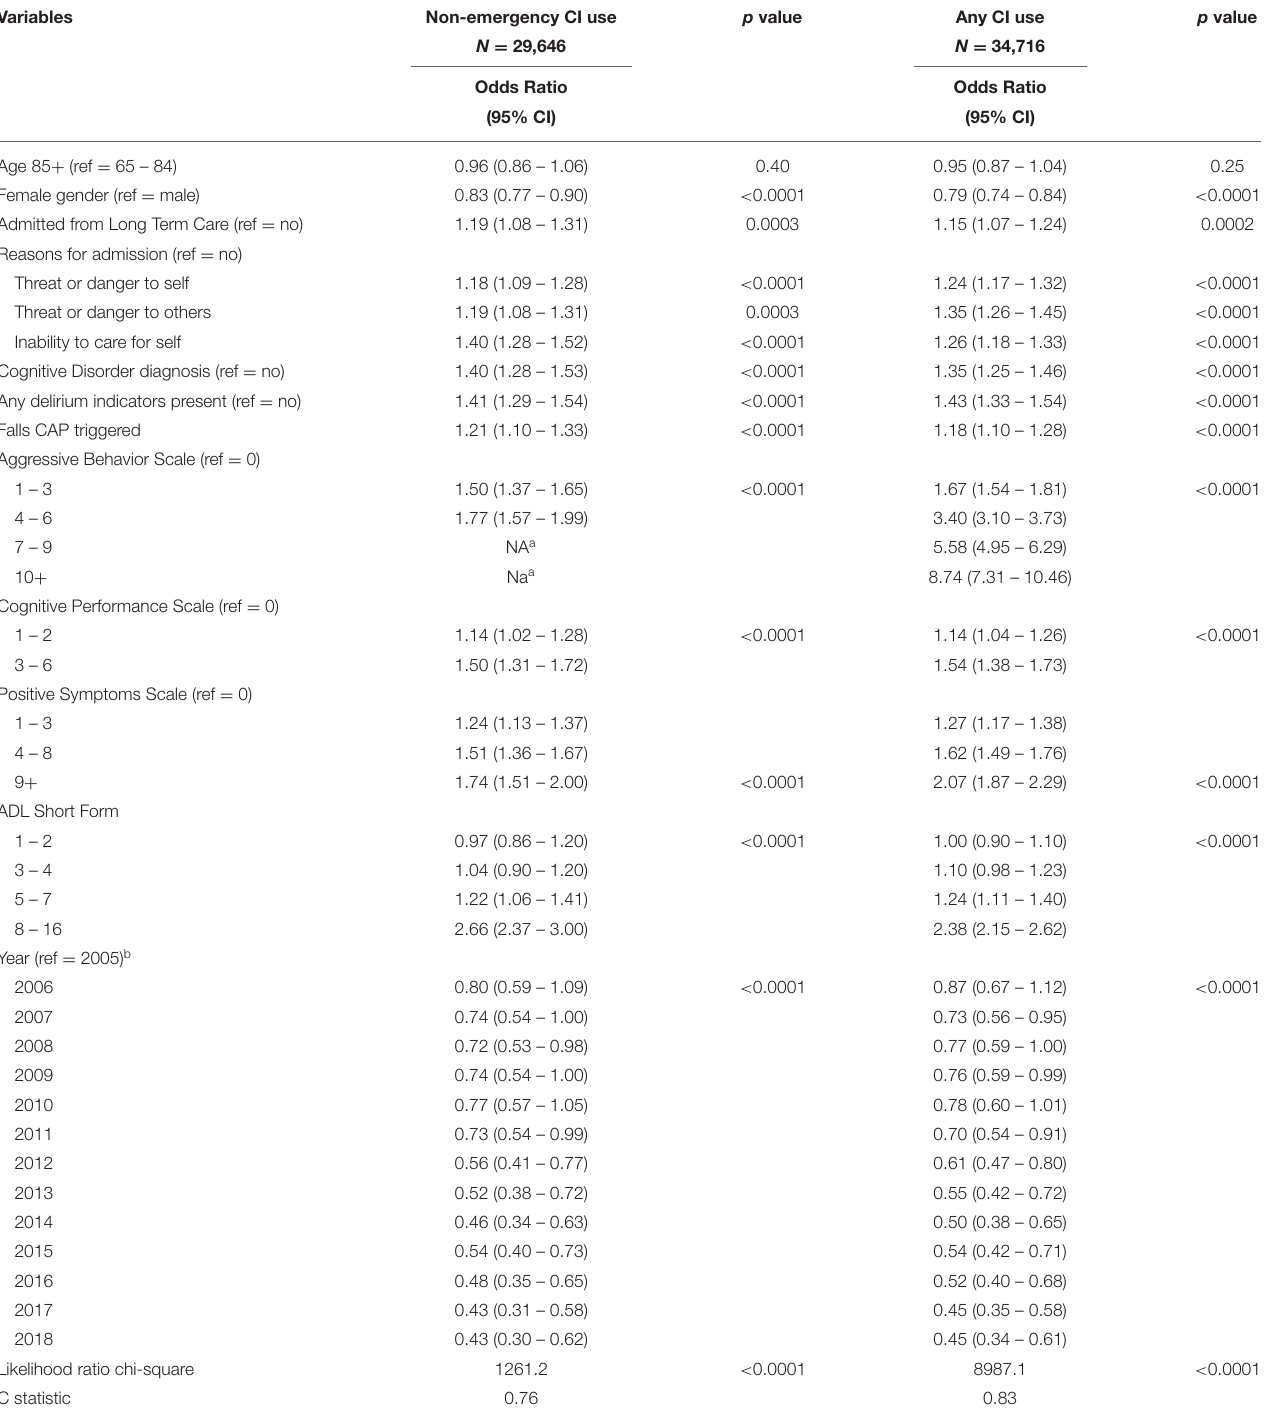
TABLE 2 | Logistic regression models examining the sociodemographic and clinical determinants of any use of control interventions (CIs), and use in non-emergency situations only.